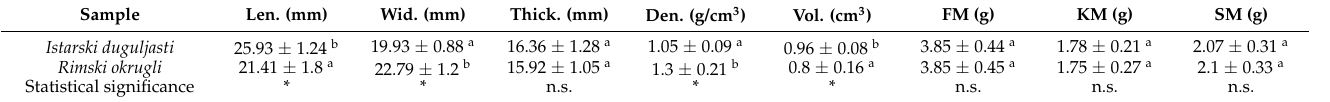
Table 1. Physical properties of observed hazelnut varieties from natural samples.